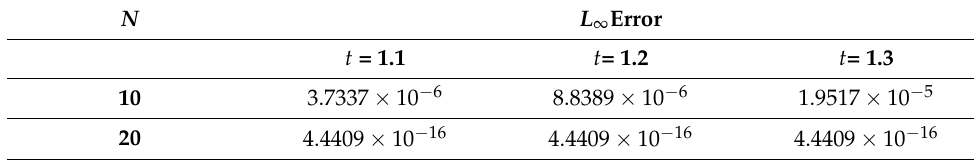
Table 5. Error analysis regarding Example 2 and 4.